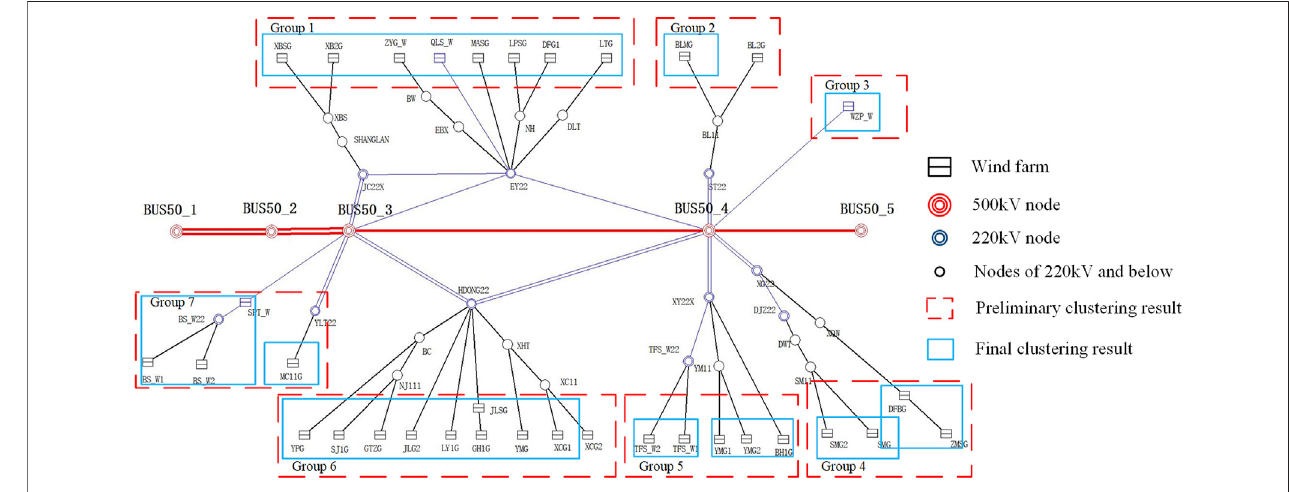
FIGURE 12 | Results of clustering among WFs.